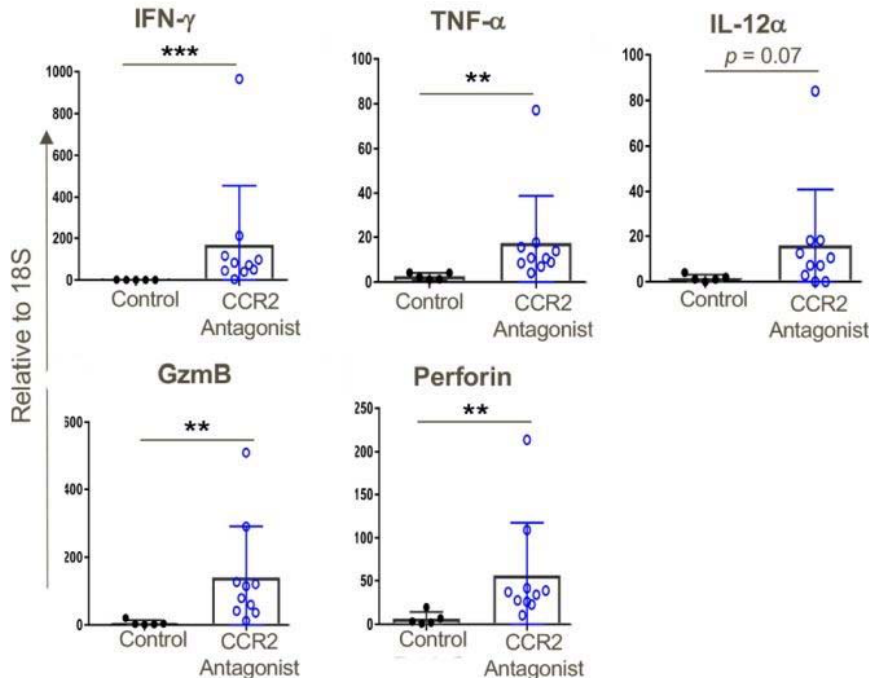
Figure 11. CCR2 antagonist treatment resulted in greater intratumoral expression of pro-inflammatory genes compared to that of tumors in vehicle-treated mice; qPCR data, ** p < 0.01, *** p < 0.001, and n = 5–10 mice / group. Data are representative of three independent